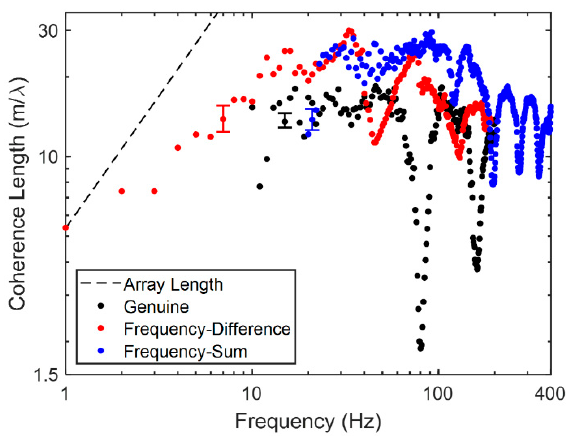
Figure 8. Coherence length (normalized by wavelength) vs. frequency comparison for the genuine and autoproduct fields on logarithmic axes. Genuine acoustic field coherence lengths are indicated by black dots for 𝑓 = 10–200 Hz while frequency-difference (-sum) coherence lengths are displayed in red (blue) for ∆𝑓 = 1–190 Hz ( Σ𝑓 = 20–400 Hz). The receiving array length is indicated by a dashed black line and nominal error bars representing the 95th percentile for each data type are indicated between 5 and 20 Hz.